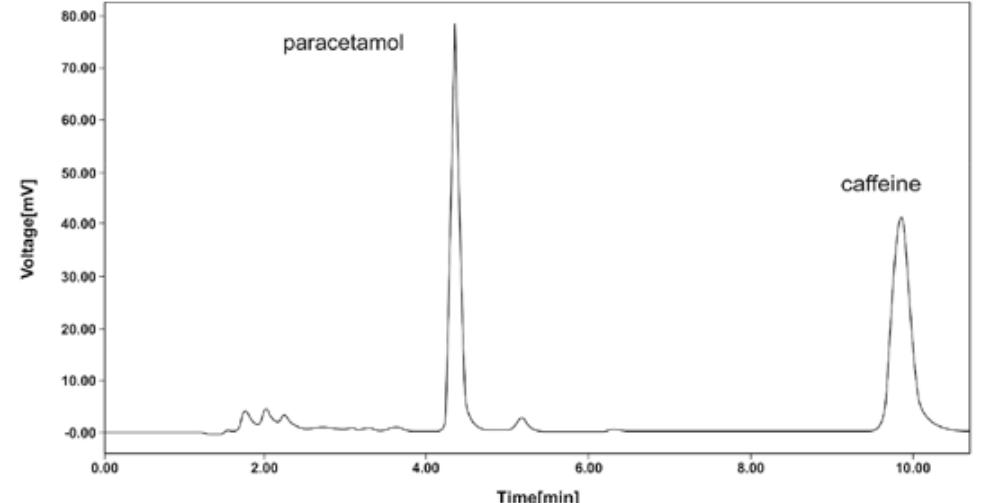
FIGURE 4 - Chromatogram of paracetamol in plasma taken from a rat after IV administration and spiked with caffeine (80 µg/mL).